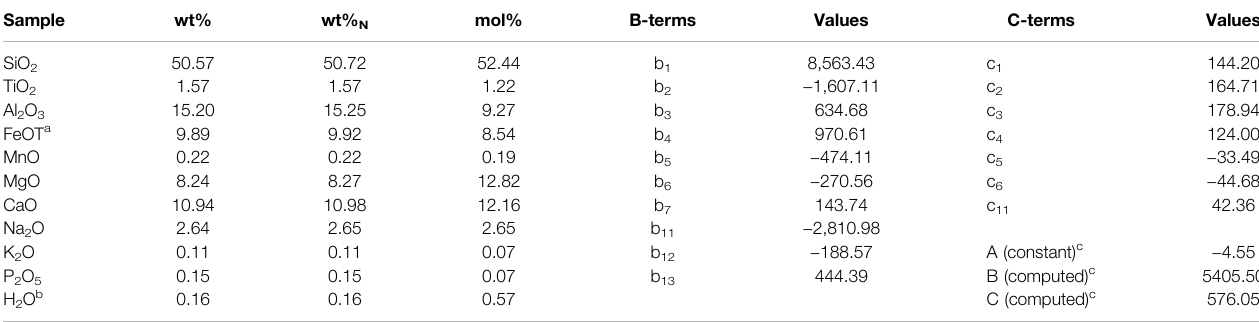
TABLE 3 | Sample calculation of viscosity (Pa · s) using model coef fi cients in Table 2